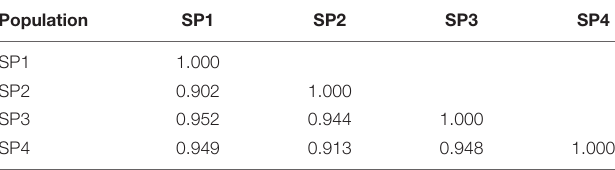
TABLE 6 | Pair-wise population matrix of Nei genetic identity.